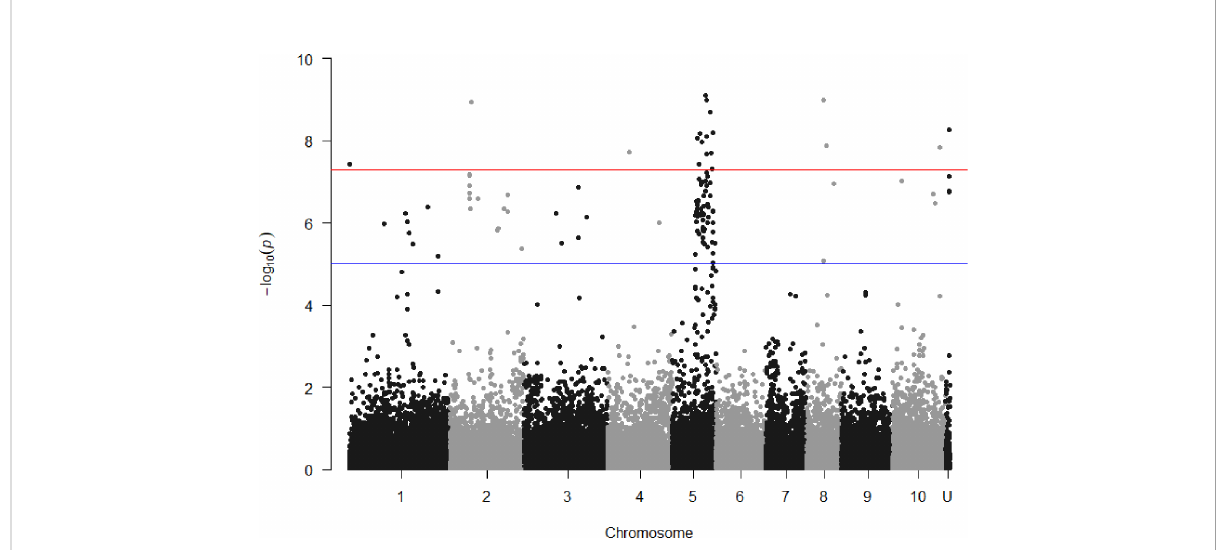
FIGURE 3 Manhattan plots showing P value of SNPs obtained from association analysis for red rot resistance score versus locational alignment to the sorghum genome (chromosomes numbered 1 to 10, U indicating no alignment found). For guidance, the red line indicates p = 5x10 -8 and the blue line p = 1x10 -5